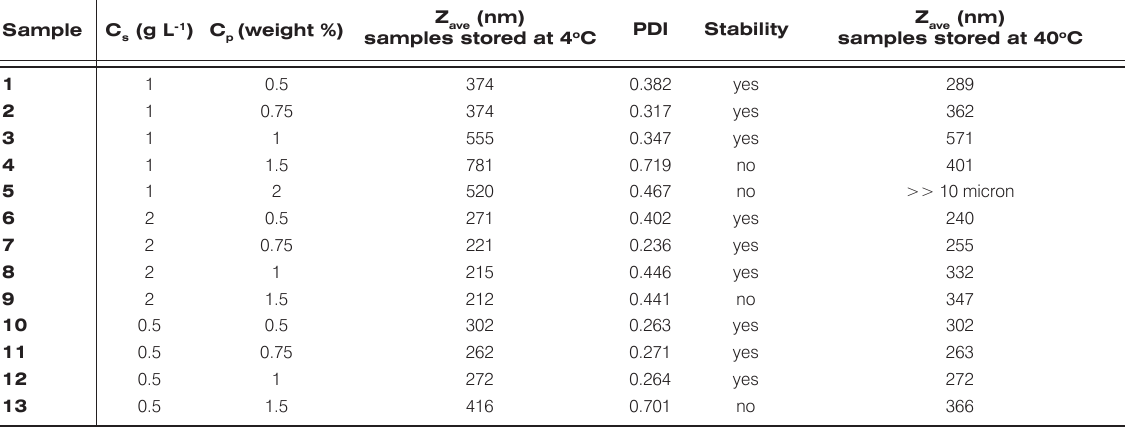
Table 1. DLS data for PDMS nanoparticles prepared in various conditions. (g L -1 ) C (weight Sample C s p